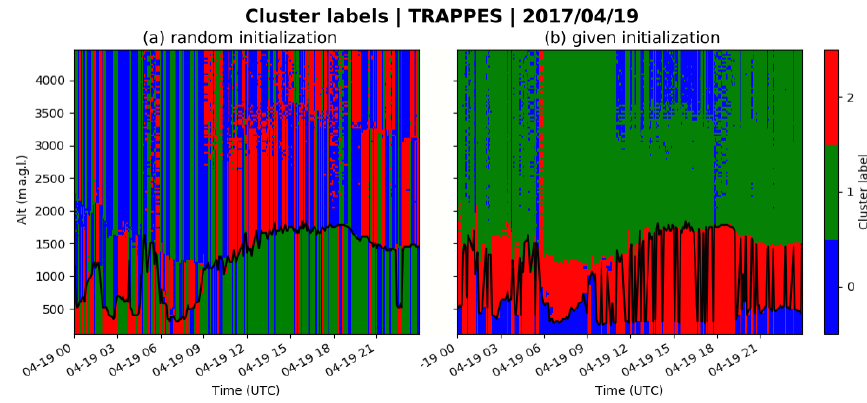
Figure 12. Cluster labels for KABL output on a time–altitude grid for 19 April 2017, at Trappes, with KABL BLH (black line) estimated using (a) the centroids initialized at random and (b) the centroids initialized at given